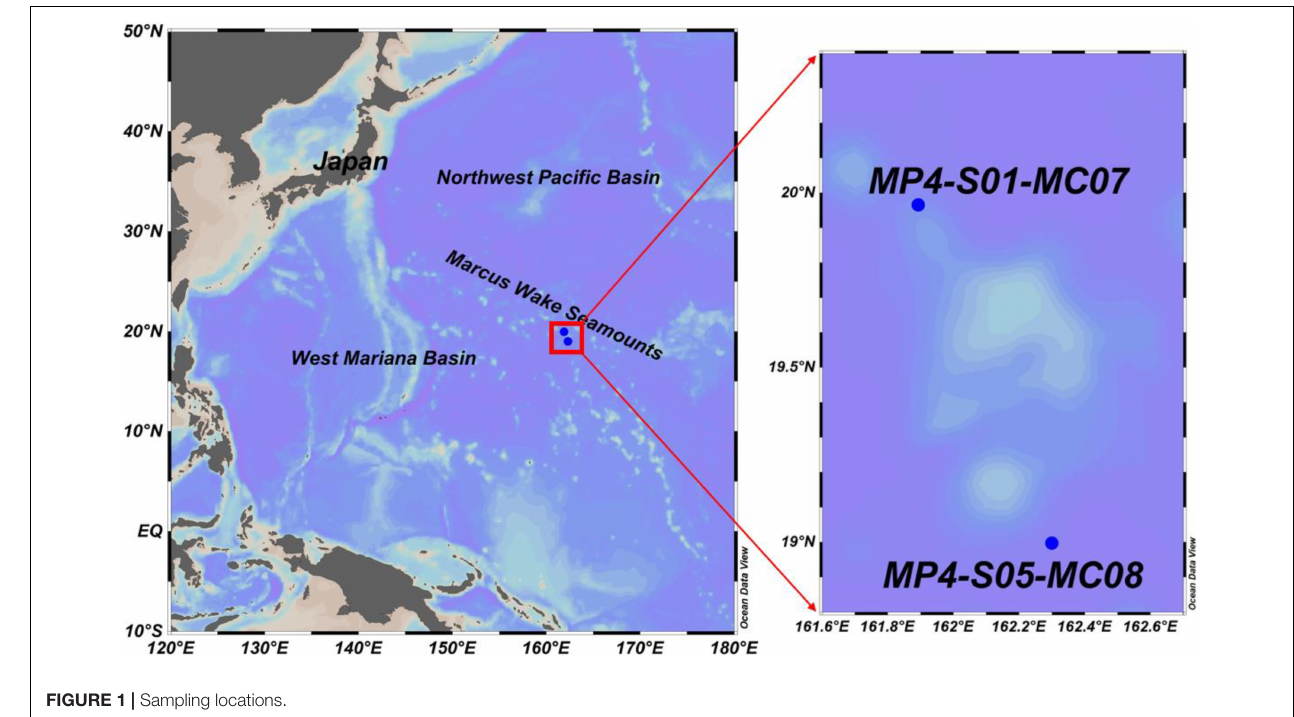
FIGURE 1 | Sampling